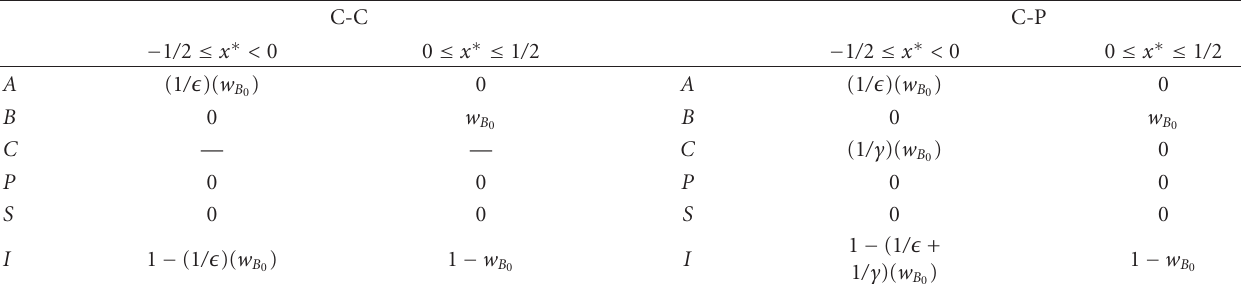
for C-C and C-P reaction 0